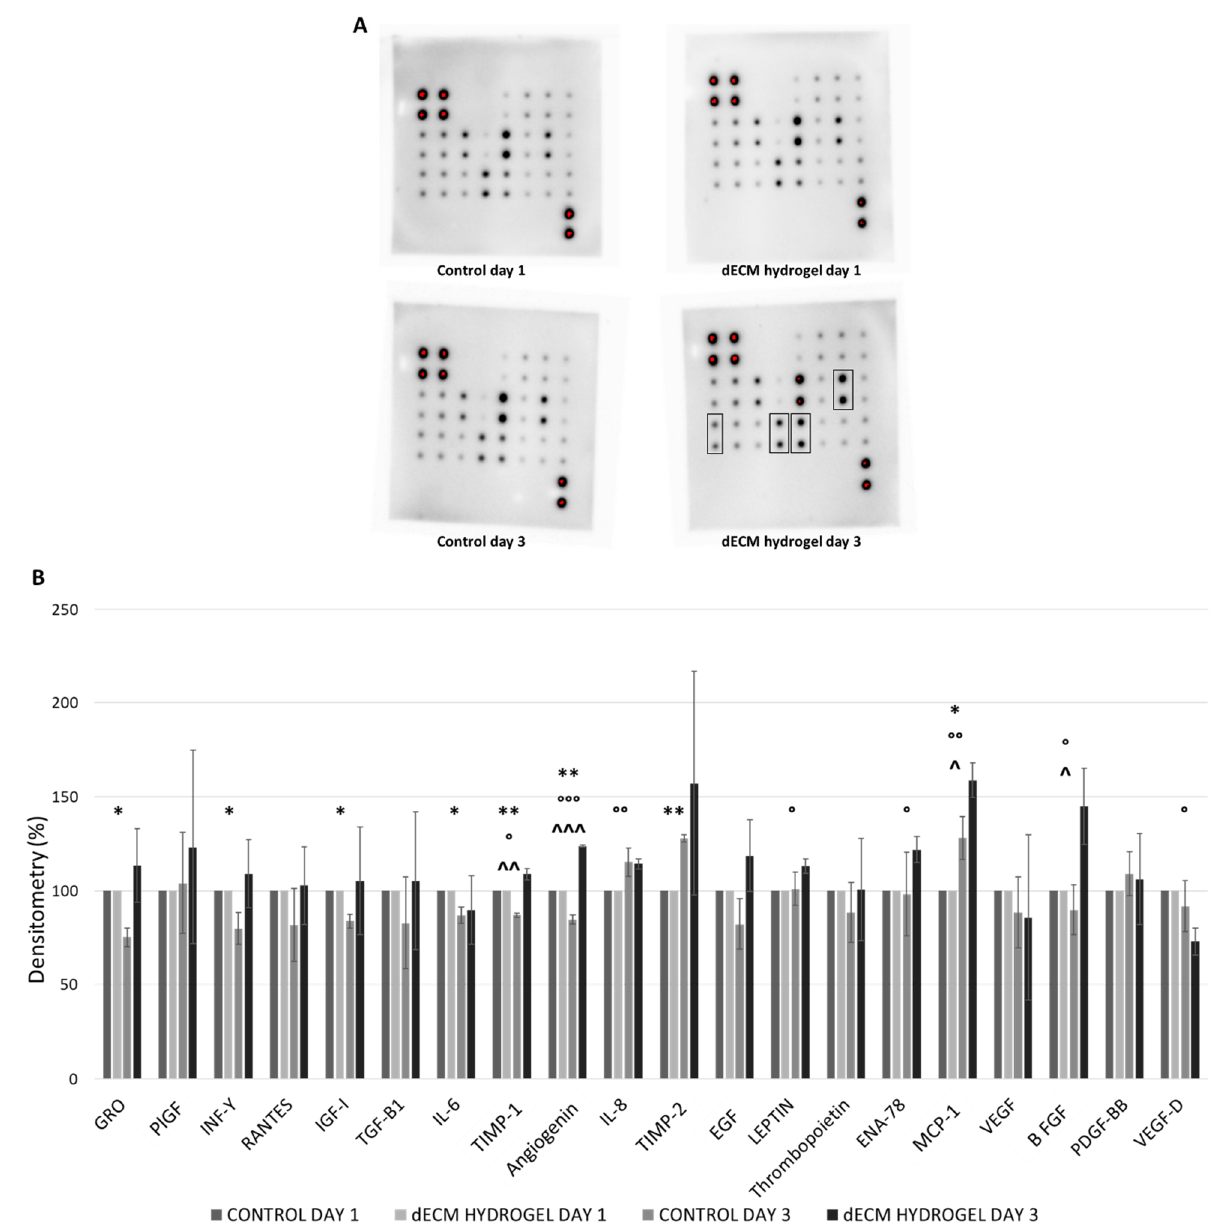
Figure 4. Angiogenic potential of dECM hydrogel. ( A ) Human Angiogenesis Antibody Array on 4 mg/mL dECM hydrogels: spot arrays in controls and hydrogels at days 1 and 3. Thicker spots on dECM hydrogel day 3 are marked in boxes. ( B ) Human Angiogenesis Antibody Array relative percentage expression of markers by HUVECs in controls and 4 mg/mL dECM hydrogels at days 1 and 3. Data are normalized according to producer’s protocol and are means ± S.D. of 3 experiments. ^: dECM hydrogel vs control at day 3; *: control day 3 vs control day 1; °: dECM hydrogel day 3 vs dECM hydrogel day 1. *, °, ^: p < 0.05; **, °°, ^^: p < 0.01; °°°, ^^^: p < 0.001.